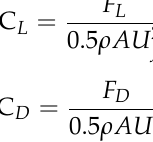
Table 6. Fin drag analysis at 20° in model scale (unit: N). Fr